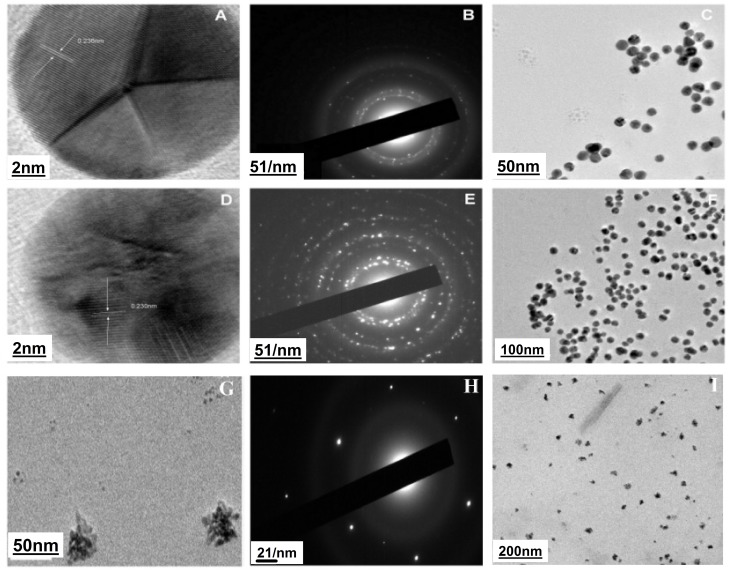
TEM analysis of AuNPs.5A, 5C High magnification TEM image of glucose capped gold nanoparticles showing FFT measurement using Image-J software; 5B SAED pattern of glucose capped gold nanoparticles; 5D, 5F High magnification TEM image of citrate -gold nanoparticles showing FFT measurement using Image J-software; 5E SAED pattern of citrate—gold nanoparticles; 5 G, 5I Shows the high magnification TEM image of 2-Deoxy-D-Glucose capped gold nanoparticles;5 H SAED pattern of 2DG-Capped gold nanoparticles.